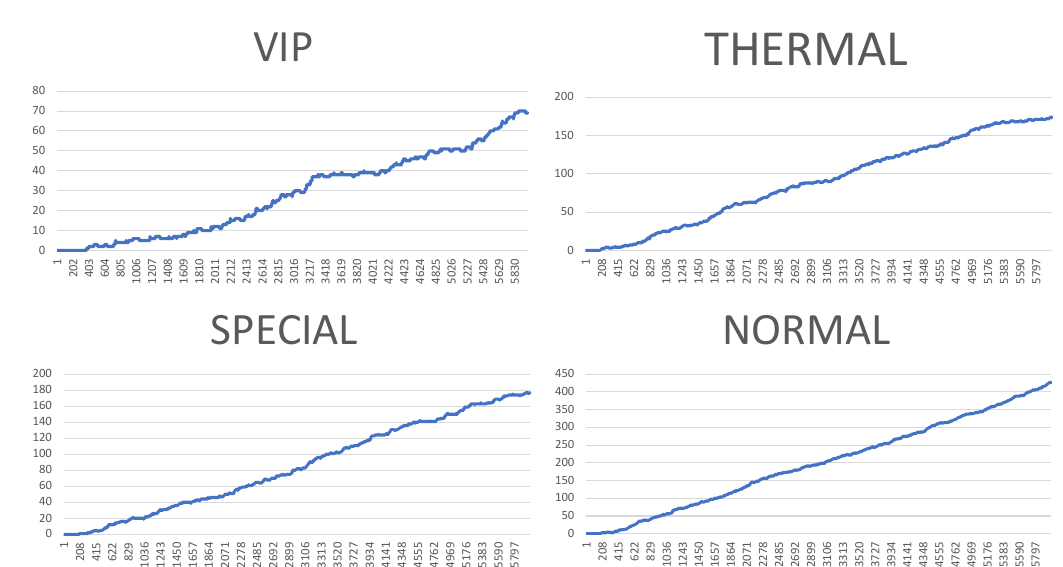
Figure 13. Results of the simulation processes carried out, or queue loads over the simulation time—ultimate mode. (Horizontal axes show the passing of simulation time from 0 to approx. 7000 s, vertical axes illustrate the current number of clients in particular